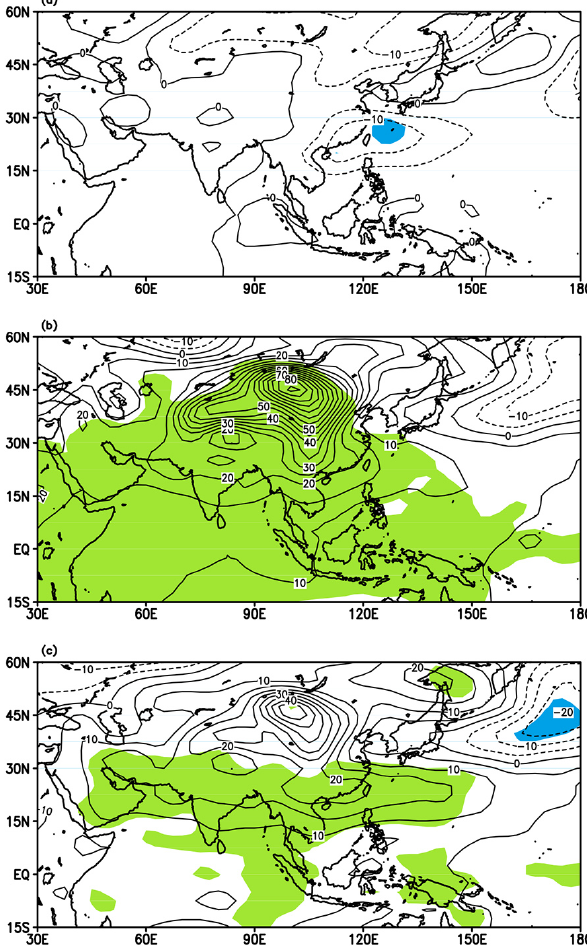
Figure 5. The composite differences of the summer 850hPa geopotential height (m) between high and low R SCS/BOB (a) , R WNP/BOB (b) , and R WNP/SCS (c) . The shaded area is above the 95% confidence